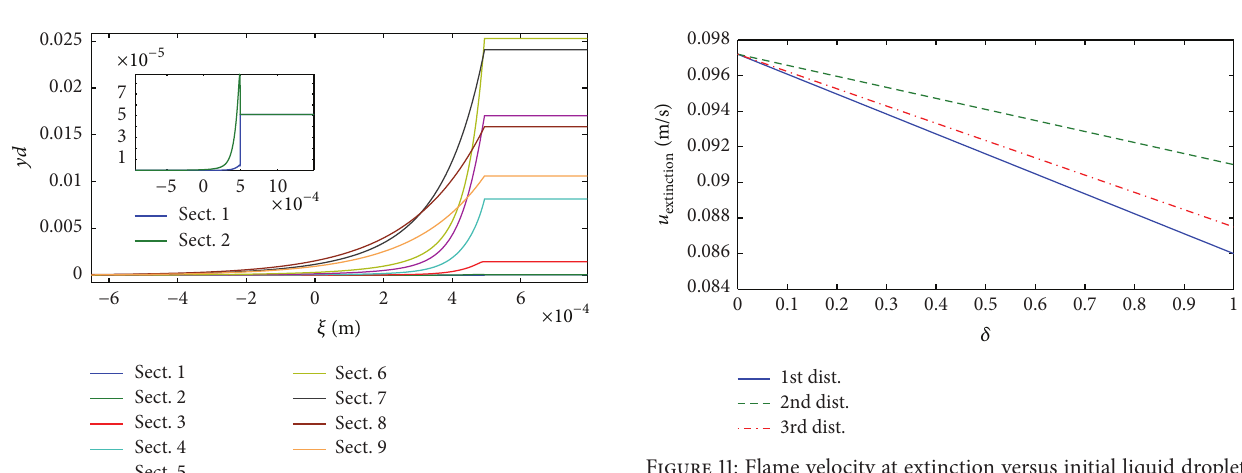
Figure 11: Flame velocity at extinction versus initial liquid droplet load—influence of initial droplet distribution.